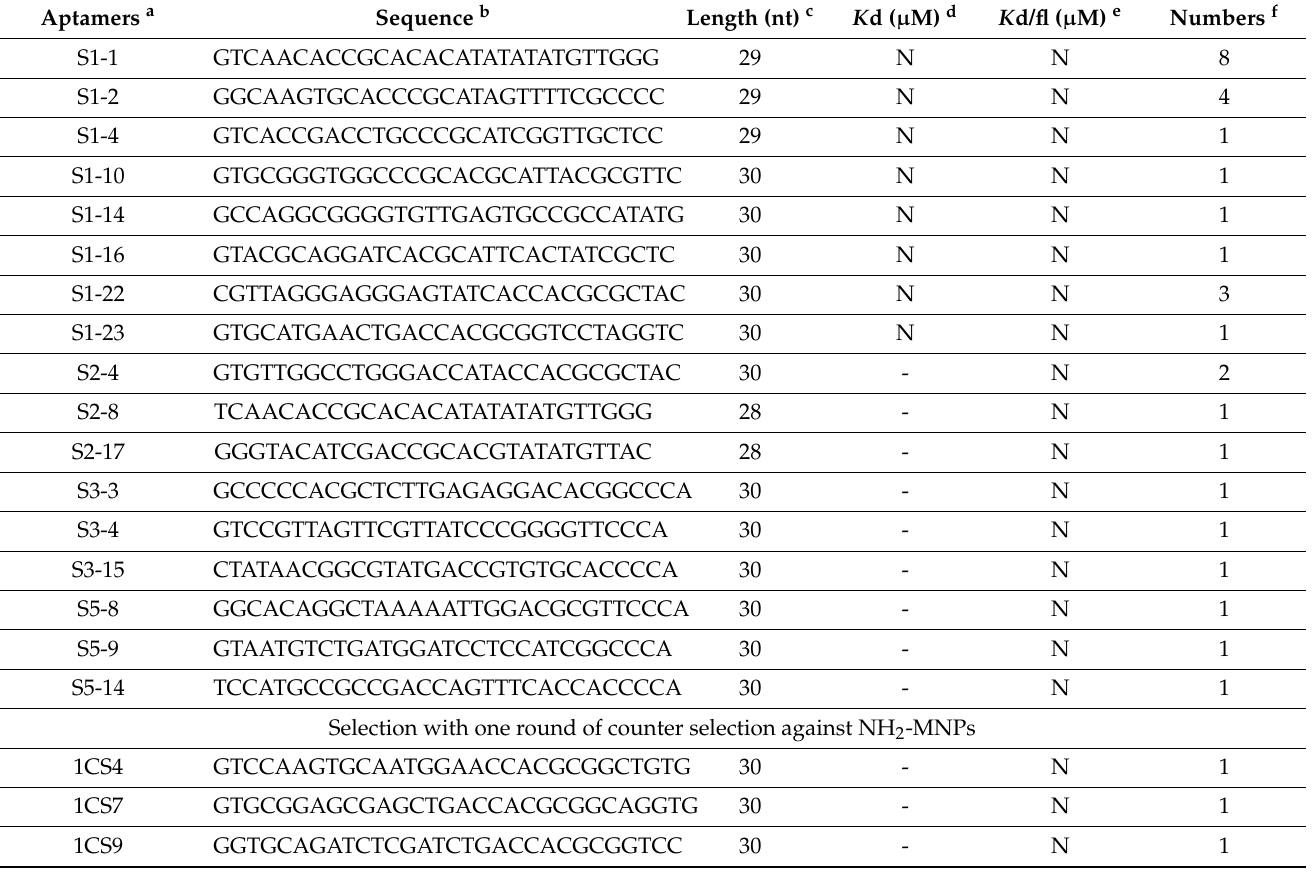
Table 1. The sequence and characteristics of the aptamers in this study.